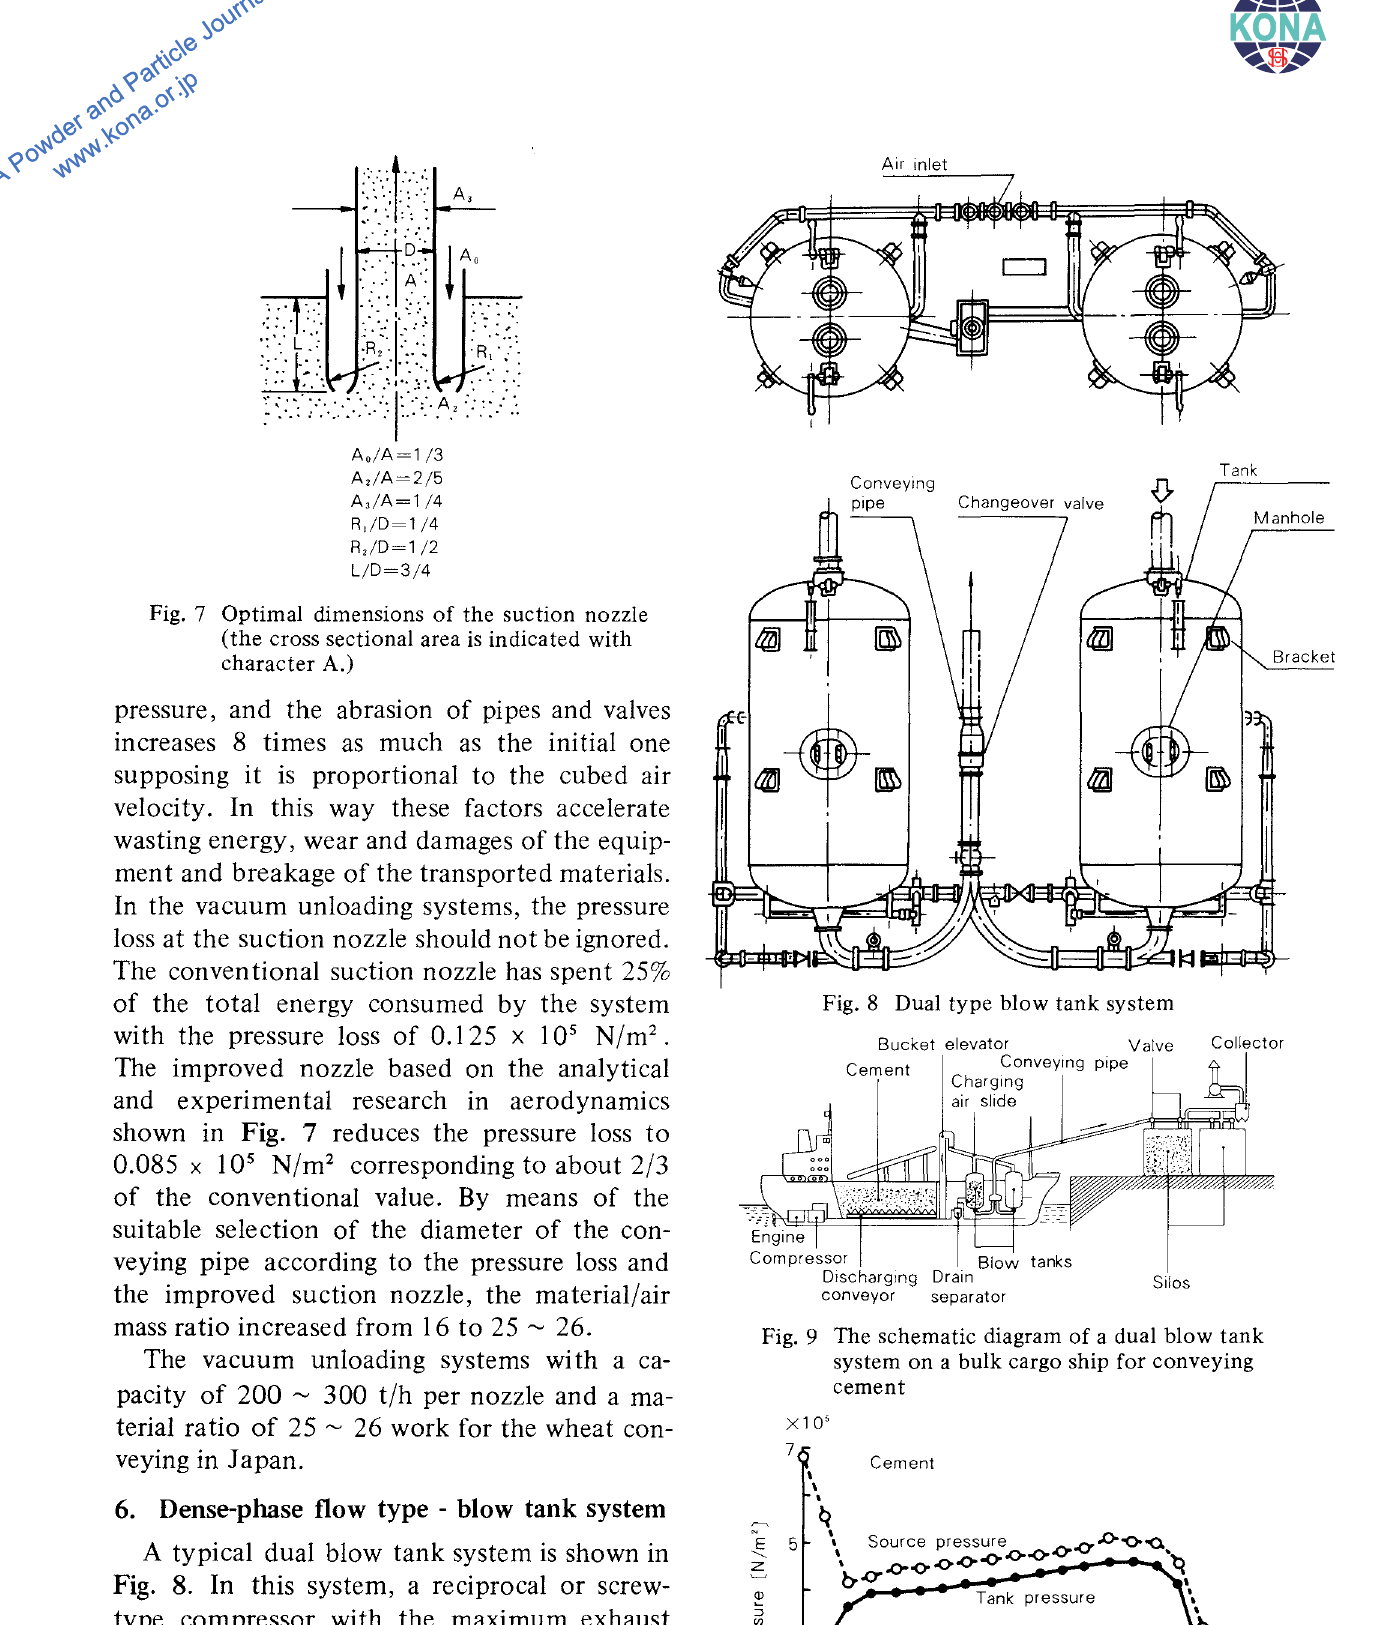
Fig. I 0 The pressure curve in a blow tank